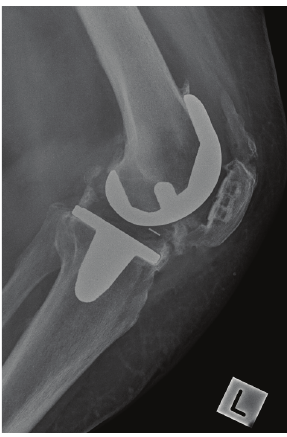
Figure 1: Postoperative radiographs of the total knee replacement at 8 months showing the severe heterotopic ossification.